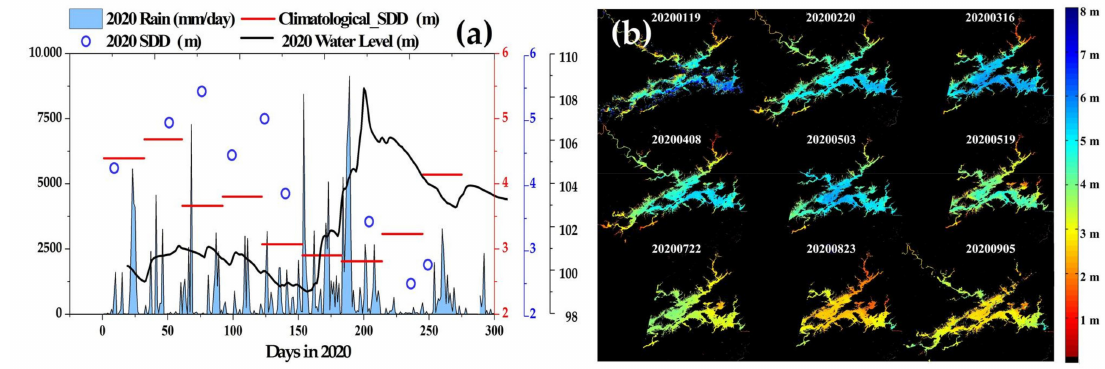
Figure 8. ( a ) Changes in SDD, water level, and total rainfall in the catchment area of the Qiandao Lake in 2020; ( b ) Spa- tiotemporal changes of satellite-derived SDD in the Qiandao Lake in